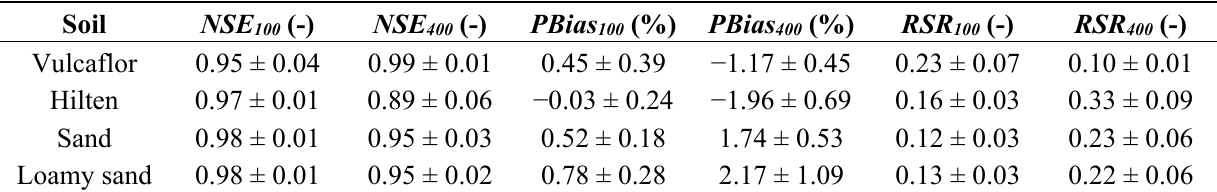
Table 5. Statistical evaluation of comparisons between the proposed FV model and